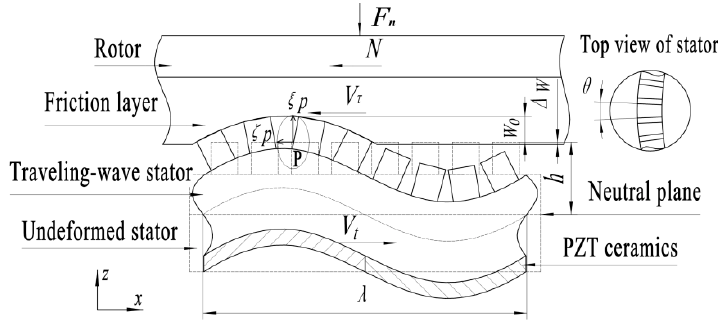
Figure 2. Contact status between stator and rotor over one wavelength.